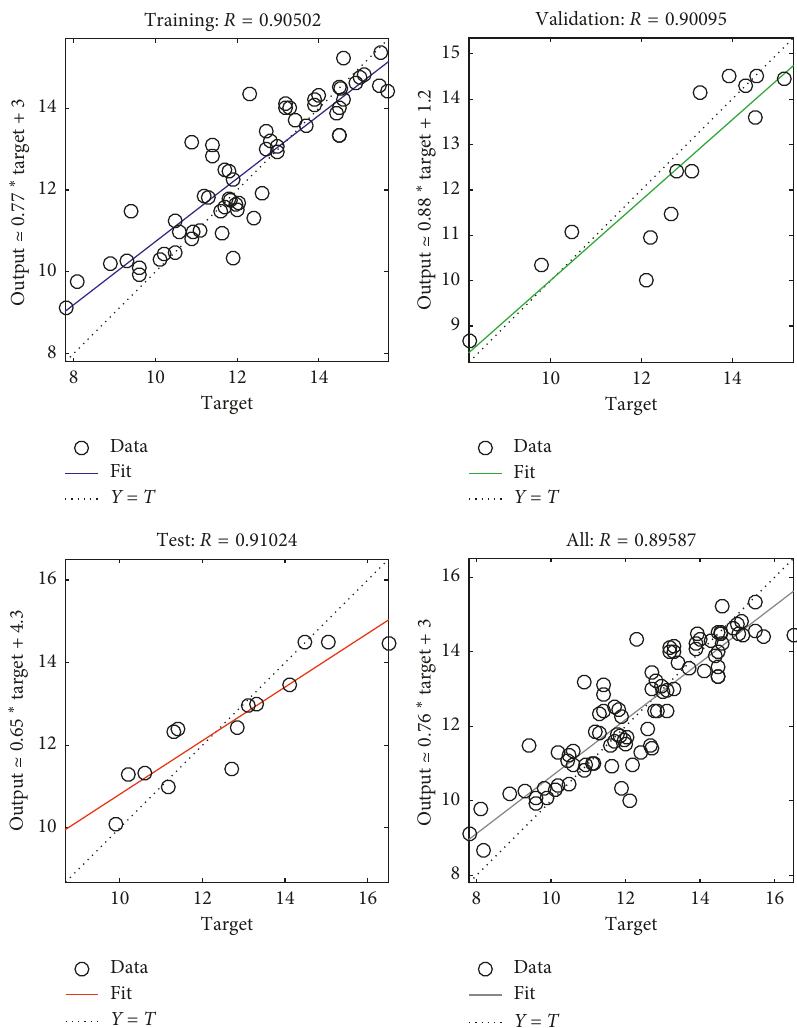
Figure 9: Training, validation, testing phases, and all data for the Marshall stability (kN) ANN